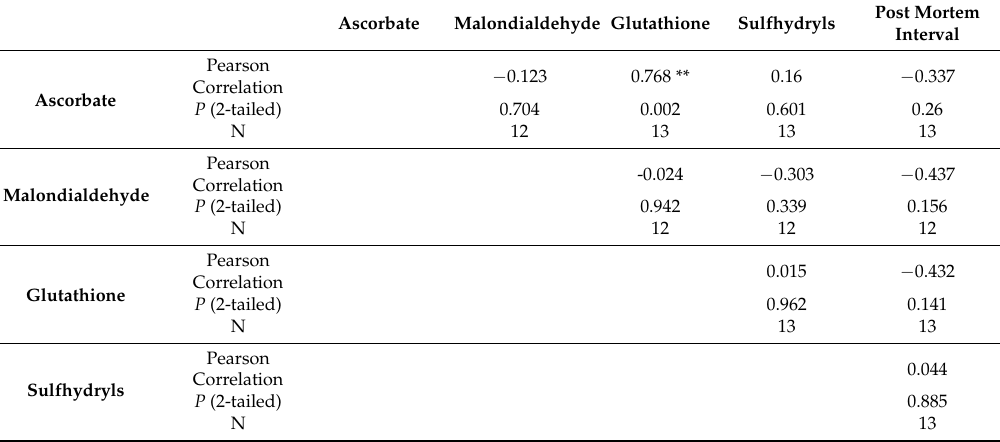
Table 2. 2-tailed correlations between PMI and biochemical measures in human brain tissue. Ascorbate Malondialdehyde